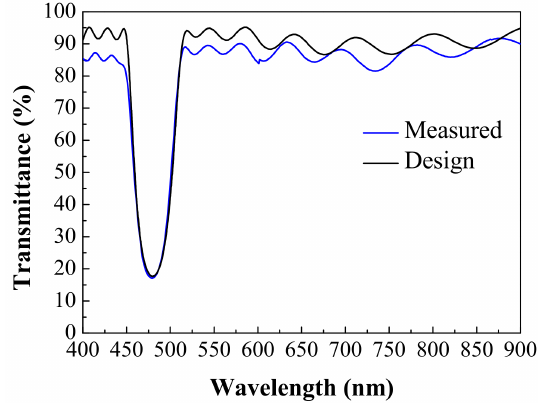
Figure 2. Transmittance spectra of a 9-layer notch filter.